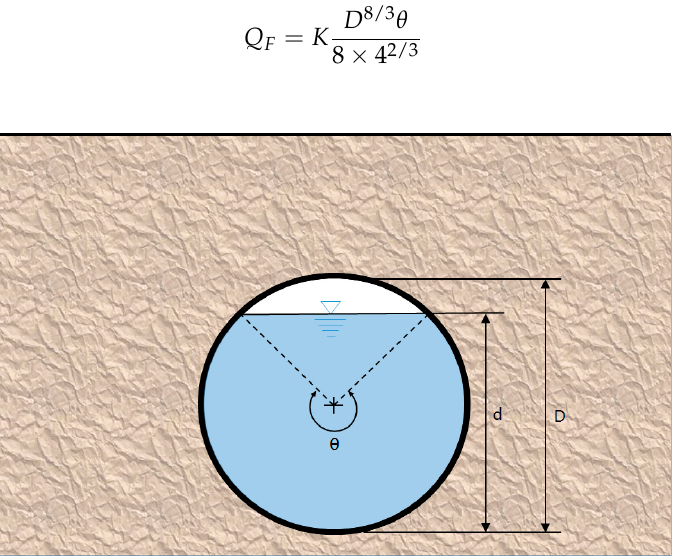
Figure 7. Schematic of uniform flow in a circular conduit.